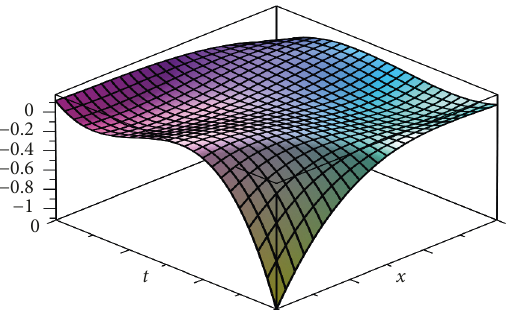
n m m 2 (cid:29) 1 (cid:29) 2 (cid:29) 3 for Example (cid:29)